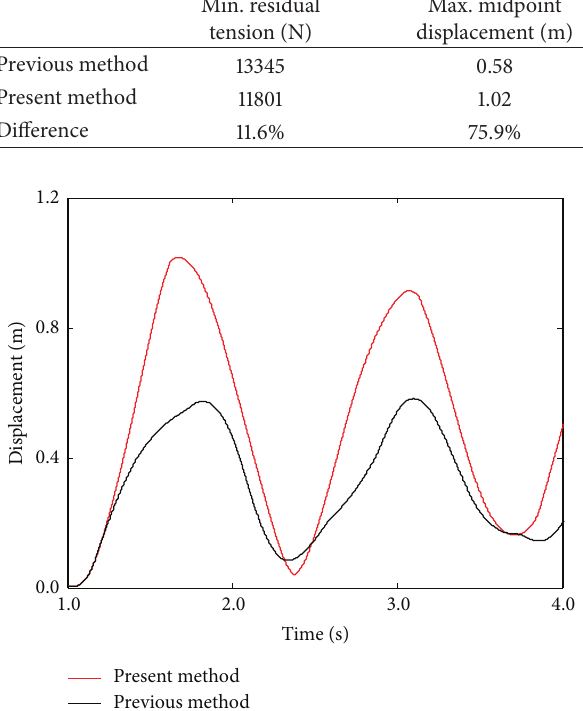
Figure 5: Displacements at the midpoint of the